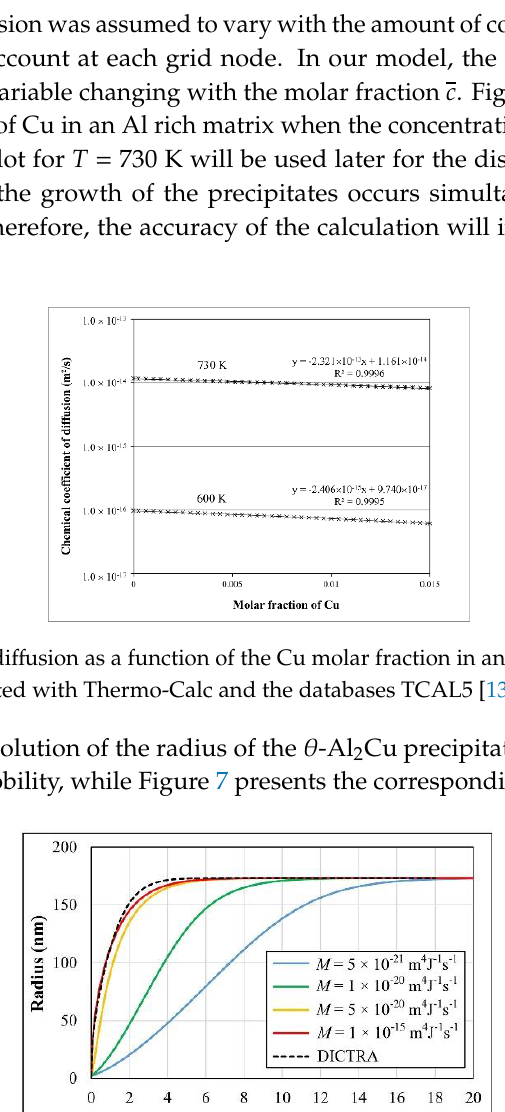
Figure 7. Evolution of c and * c for a spherical  -Al 2 Cu precipitate growing in a finite Al-1.0 at%Cu matrix with different values for the interfacial mobility. As far as the comparison with DICTRA is concerned, one can say that the case with M = 1.0 × 10 −15 m 4 /J/s gives a very close agreement with the DICTRA simulation. With such a high interfacial mobility, we have * c ≈ eq c  , so one can consider that the growth regime is essentially diffusion- controlled in this circumstance. It is worthwhile to mention that the value of a c has a negligible impact on the results when the interfacial mobility is such that growth or dissolution can be assumed to be diffusion-controlled. This stems from the fact that when the kinetics of phase transformation are diffusion controlled, the k -parameter is assumed to be very high, which is consistent with a diffusion- controlled regime starting almost at time zero. The DICTRA curves start to deviate slightly from the high M case for a time > 1 h. To understand the origin of this deviation, one may consider the impact of the number density in the size evolution. Figure 8 presents the evolution of the radius (on a logarithmic scale) as computed with three different values of the number density. One can see that the discrepancy between the DICTRA curves and the model is reduced as the number density